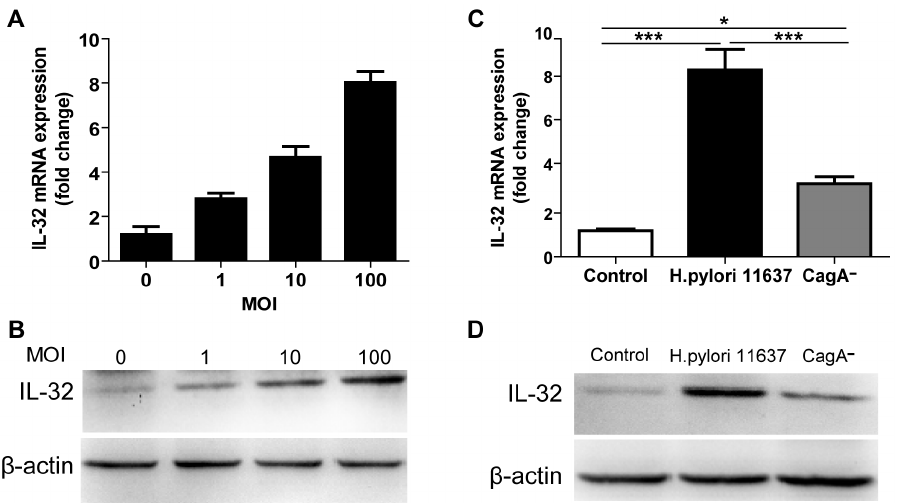
Figure 4. IL-32 induction in response to H.pylori infection. A. IL-32 mRNA level were assessed in AGS cells after H. pylori 11637 strain infection for 24 hours at a MOI of 1, 10, 100; B. IL-32 protein level were detected in (A); C. AGS cells were stimulated with either H. pylori 11637 strain or its isogenic CagA-negative mutant strain for 24 hours, and then the mRNA level of IL-32 was analyzed. Data are mean 6 SEM of three separate experiments. * P , 0.05; *** P , 0.001; D. The protein level of IL-32 was detected and one representative blot was shown from (C).